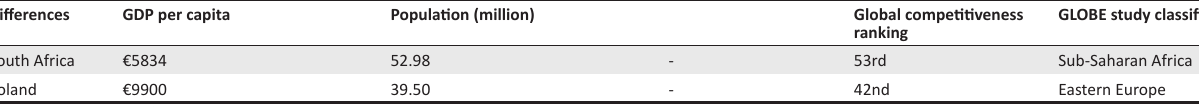
TABLE 1b: Differences comparison of South Africa and Poland.